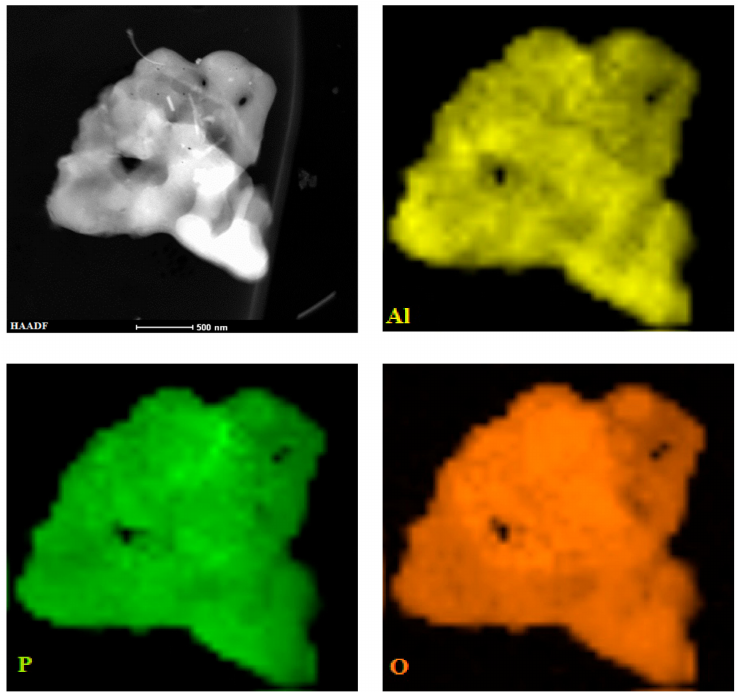
Figure 9. HAADF-STEM imaging and EDX mapping on a single particle showing Al, O, and P elemental